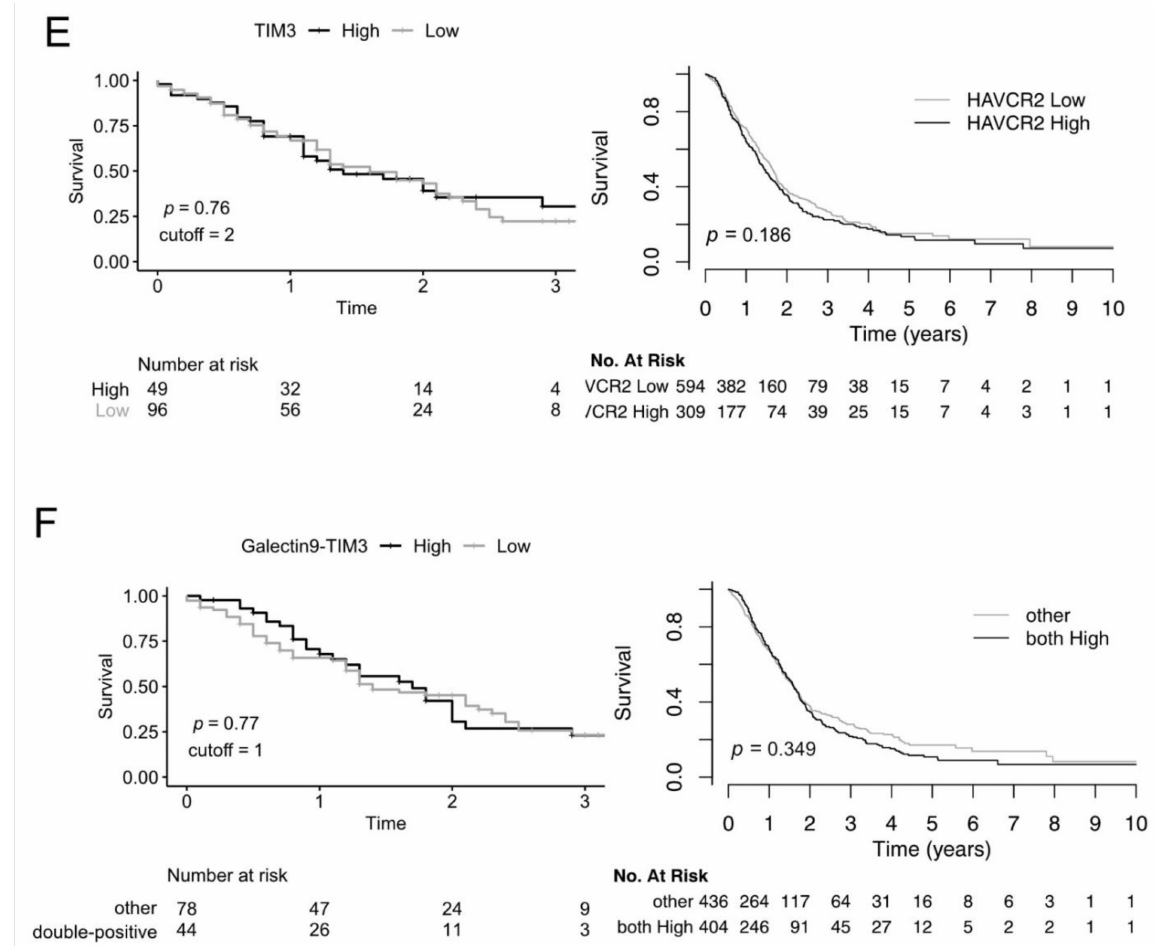
Figure 3. Overall survival related to the expression of the immune molecules. ( A ) Kaplan–Meier estimates of overall survival of patients with IDO-positive tumors (high) vs. IDO-negative/low-expressing tumors (low) assessed with immunochemistry on the TMA (left, n = 151, p = 0.037, log-rank test). Survival of patients from public transcriptomic databases with IDO- low-expressing ( ≤ 66th percentile) vs. IDO-high-expressing (>66th percentile) tumors. The overall survival is statistically equivalent ( n = 903, p = 0.832, log-rank test, right). ( B ) Survival of patients with CD3-high infiltrating tumors (high - score 3) vs. CD3-low infiltrating tumors (low - scores 1 and 2; n = 128, p = 0.257, log-rank test). ( C ) Survival of the TMA cohort patients with VISTA-positive tumors (high) vs. VISTA negative/low-expressing tumors (low) (left, n = 152, p = 0.091, log-rank test). Survival of patients from public transcriptomic databases with VSIR-low-expressing ( ≤ 66th percentile) vs. VSIR-high-expressing (>66th percentile) tumors. The overall survival is statistically equivalent ( n = 233, p = 0.738, log-rank test, right). VSIR encodes the VISTA protein. ( D ) Survival of the TMA cohort patients with LAG3-positive/low-expressing tumors (positive) vs. LAG3 negative-expressing tumors (negative) (left, n = 124, p = 0.11, log-rank test). Survival of patients from public transcriptomic databases with LAG3-low-expressing ( ≤ 33rd percentile) vs. LAG3-high-expressing (>33rd percentile) tumors. The overall survival is statistically equivalent ( n = 903, p = 0.413, log-rank test, right). ( E ) Survival of the TMA cohort patients with TIM3-positive tumors (high) vs. TIM3-negative/low-expressing tumors (low) (left, n = 145, p = 0.76, log-rank test). Survival of patients from public transcriptomic databases with HAVCR2-low-expressing ( ≤ 66th percentile) vs. HAVCR2-high-expressing (>66th percentile) tumors. The overall survival is statistically equivalent ( n = 903, p = 0.186, log-rank test, right). HAVCR2 encodes the TIM3 protein. ( F ) Survival of Galectin 9–TIM3 double-positive patients (double-positive) vs. the remaining patients (other, left, n = 122, p = 0.77, log-rank test). Survival Galectin 9–TIM3 high (both high) patients from public transcriptomic databases (>33rd percentile) vs. Galectin 9–TIM3-low-expressing ( ≤ 33rd percentile) tumors. The overall survival is statistically equivalent ( n = 208, p = 0.349, log-rank test,